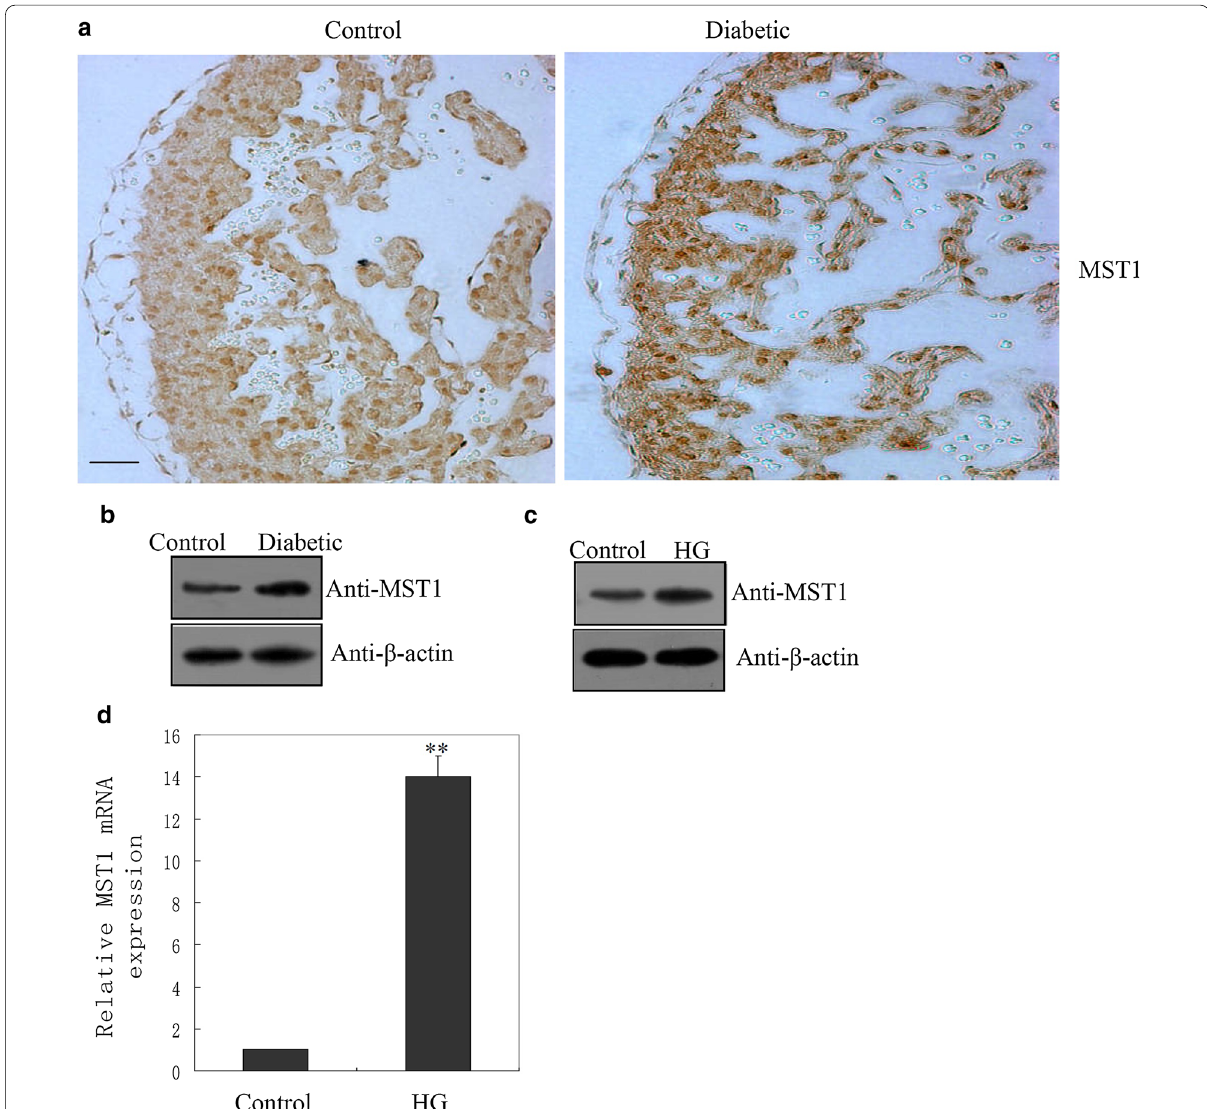
Fig. 1 Increase in mammalian sterile 20-like kinase 1 (MST1) in the cardiomyocytes of diabetic offspring in vivo. a Immunostaining of MST1 in the myocardium of normal and diabetes-exposed embryos at E15.5 (n 3). Scale bar: 50 µm. b Western blotting with the indicated antibodies in the = diabetes and non-diabetes groups (n 8 each) confirmed the increase in MST1 protein in heart tissues. β-Actin was used as an internal reference = control. Western blotting of MST protein ( c ) and real-time PCR of MST1 mRNA expression ( d ) in cardiomyocytes after 2 days of high glucose (HG) treatment. Data are based on three independent